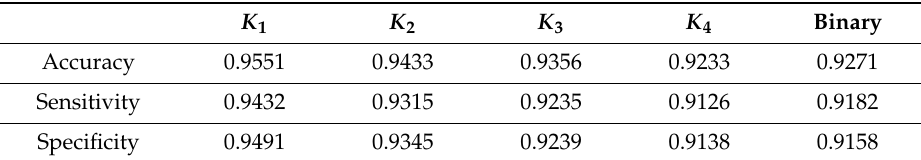
Table 1. Validation of the performance accuracy.